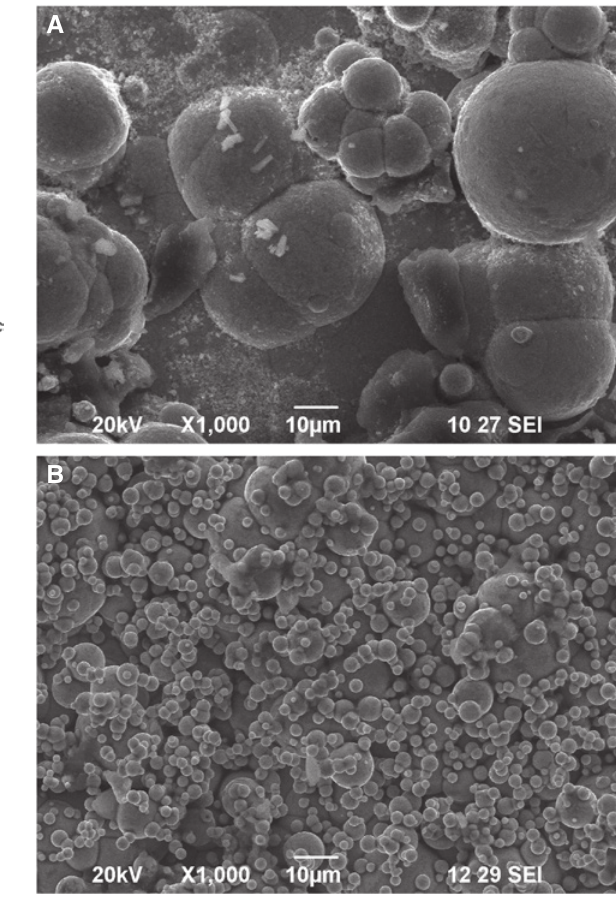
composite coating. 2